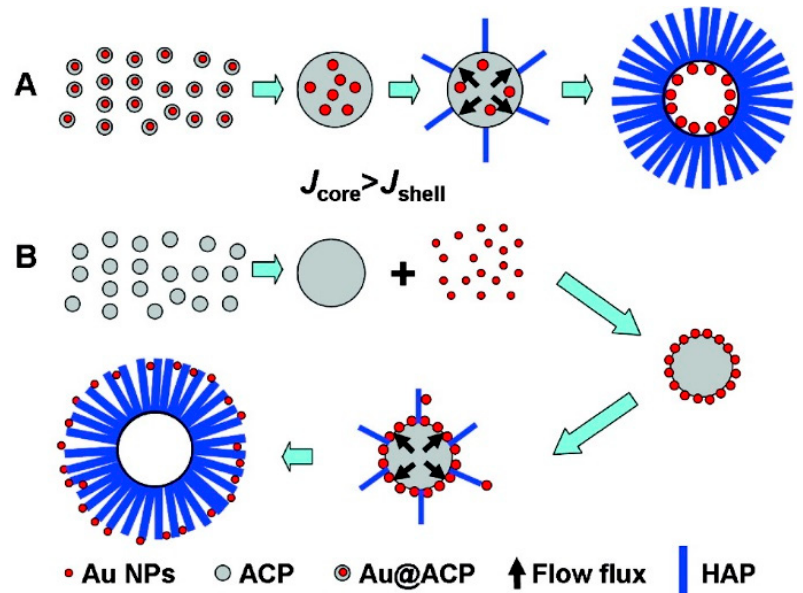
Figure 4. Schematic illustration of the evolution of amorphous calcium phosphate (ACP) probed by gold nano-particles (AuNPs) ( A ) for self-aggregation and Kirkendall process or ( B ) the surface of ACP sphere solution-mediated interface reaction. Reproduced with permission from the American Chemical Society in Reference [82].